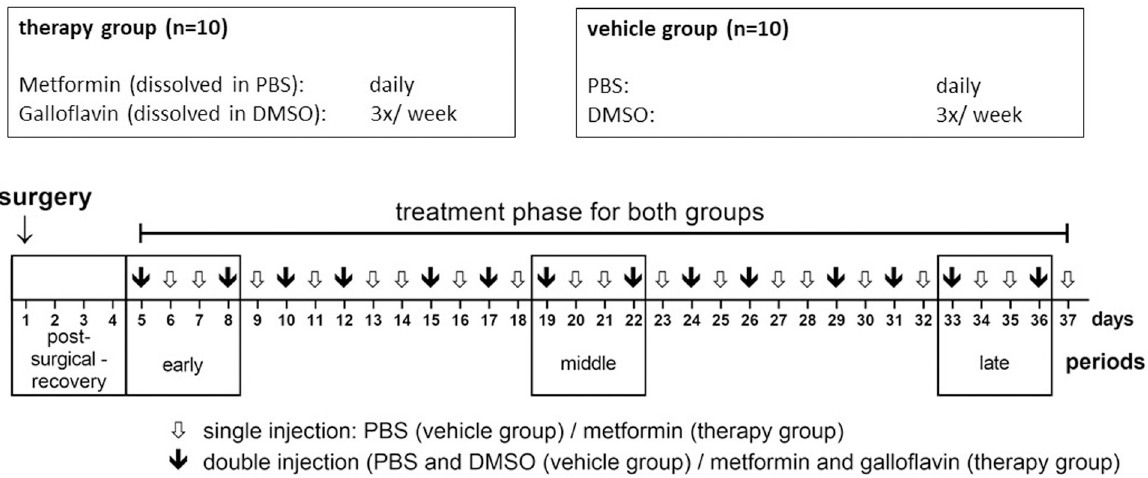
Fig 1. Experimental timeline. Black frames (“ □ ”) indicate different periods (post-surgery, early, middle, late) as well as respective days of subsequent analysis; arrows indicate single (white arrow) and double (black arrow) injection days.